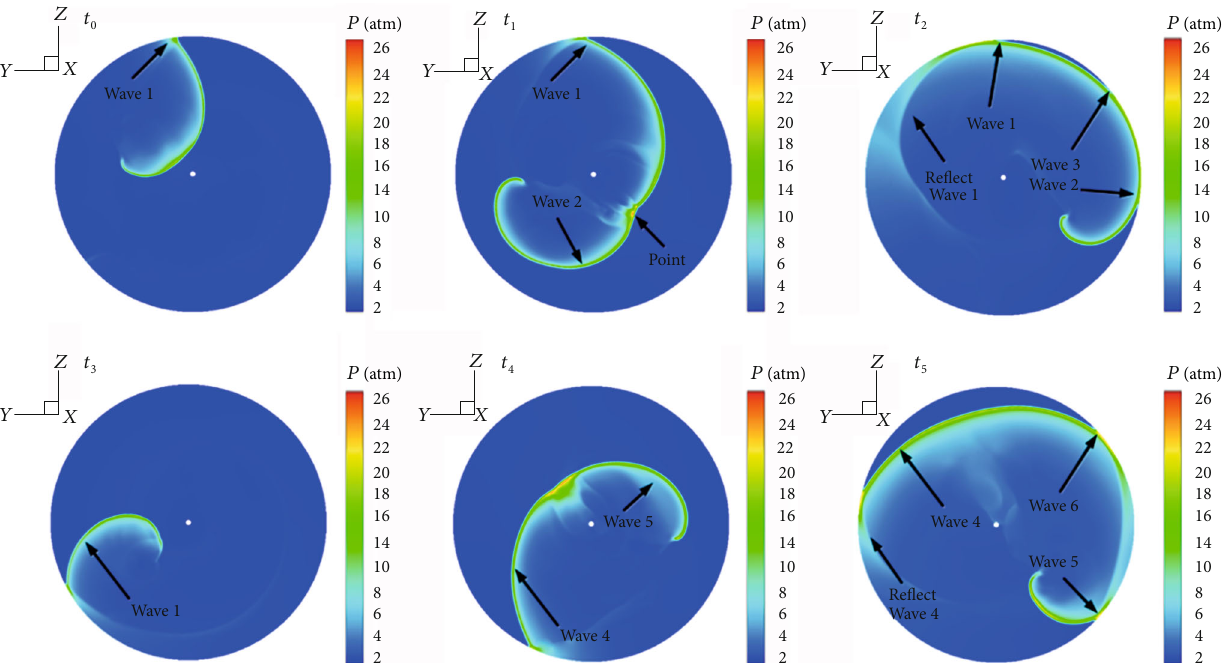
Figure 16: The process of the propagation at the